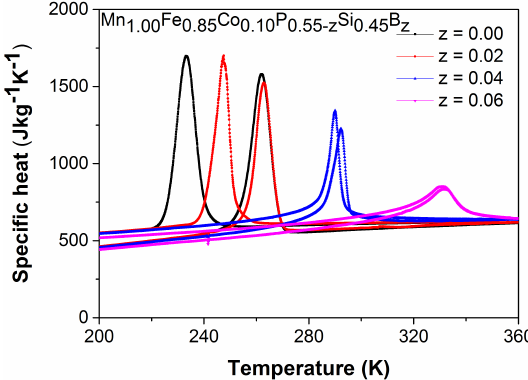
Figure 4. Specific heat derived from Differential scanning calorimetry (DSC) measurements for the Mn 1.00 Fe 0.85 Co 0.10 P 0.55 − z Si 0.45 B z compounds measured in the zero field upon cooling and